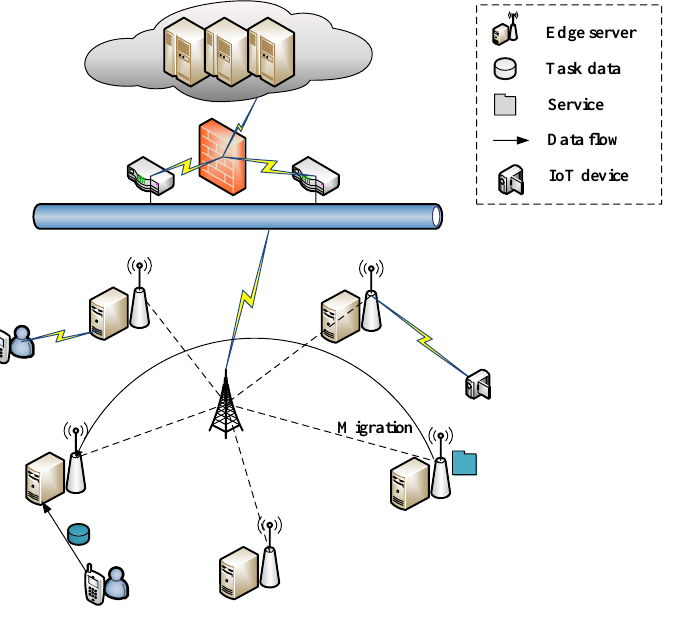
Figure 1. System